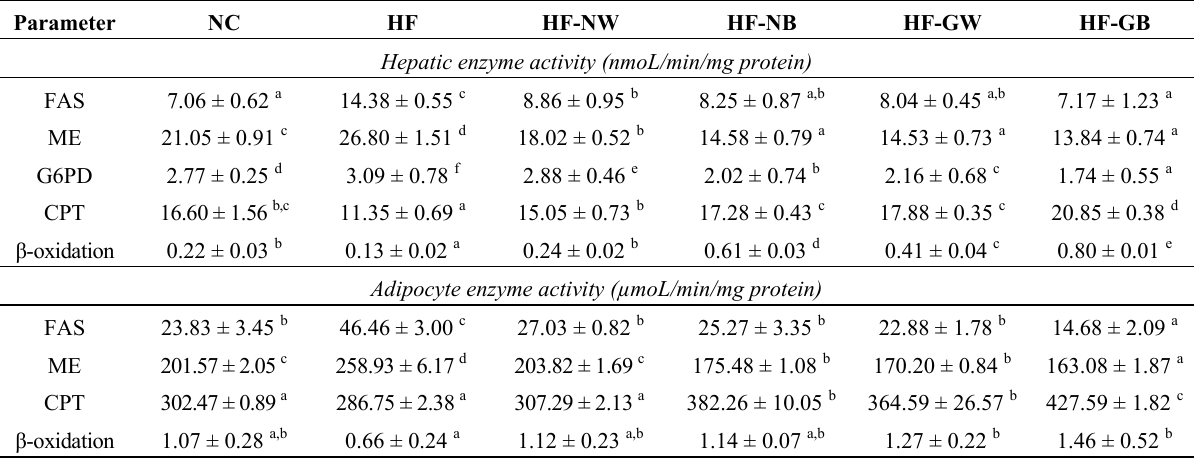
Table 5. Lipid-regulating enzyme and β -oxidation activities in mice fed with high fat diet supplemented with instant cooked rice.